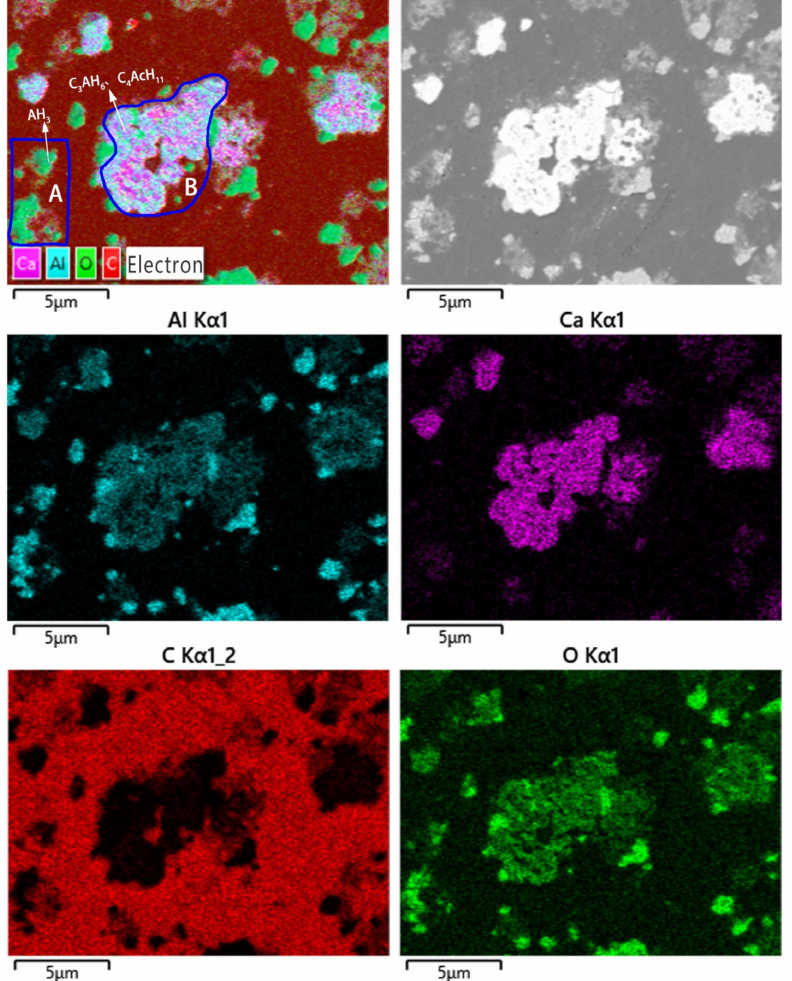
Figure 5. SEM image and EDS mapping of vaterite-type precipitated calcium carbonate